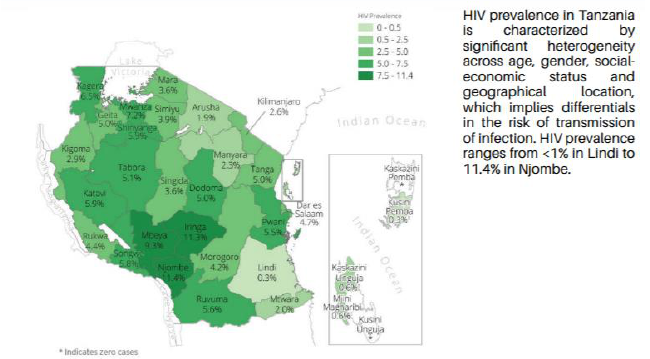
Figure 1: Tanzania Map, the geographical prevalence of HIV. (Source: THIS 2016-2017)